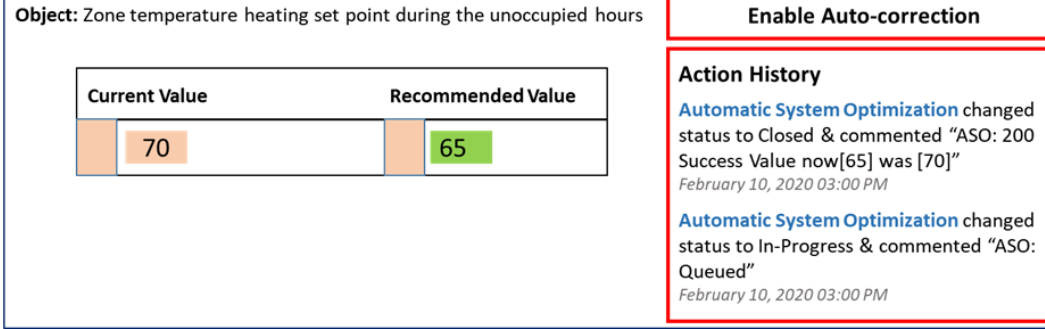
Figure 10. Mockup of the new user interface (UI) developed by one partner, displaying the auto-correction enable/disable functionality, the action history and other details (ASO – Automatic System Optimization).